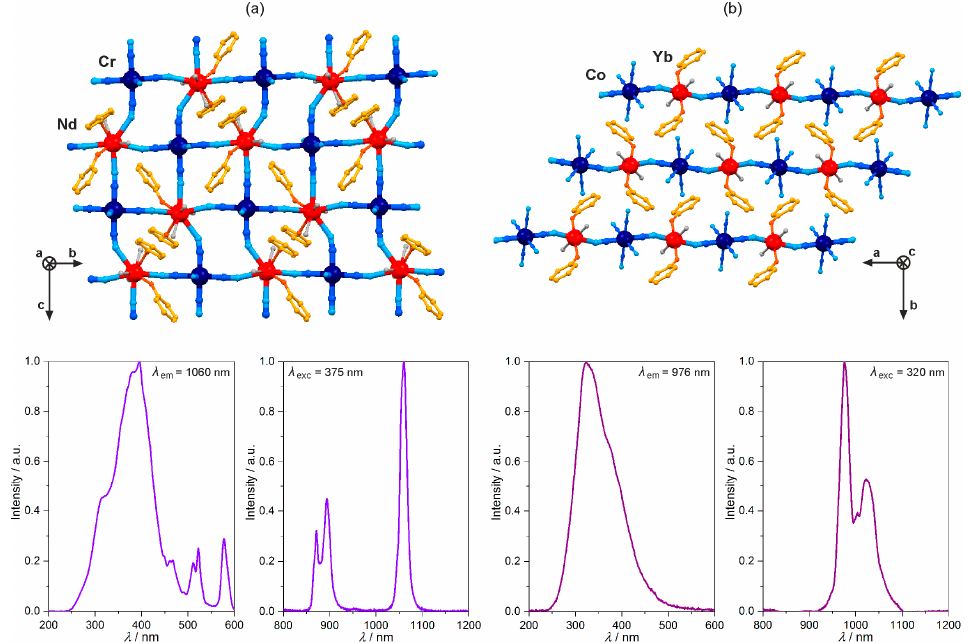
Figure 6. Crystal structure and optical properties of near-infrared (NIR)-emitting cyanido-bridged [Nd III (pmmo) 2 (H 2 O) 3 ][Cr III (CN) 6 ] ( a ) (pmmo = pyrimidine N-oxide) and [Yb III (3-pyone) 2 (H 2 O) 2 ][Co III (CN) 6 ] ( b ) (3-pyone = 3-pyridone) coordination polymers. The top part of the figure shows the respective coordination skeletons of square grid layers ( a ) and nearly linear chains ( b ), while the bottom part presents the room temperature excitation and NIR-emission spectra under the indicated wavelength conditions. Colours for the structural diagrams: Nd/Yb, red; Co/Cr, dark blue; CN − , blue; pmmo/3-pyone, orange; H 2 O, grey